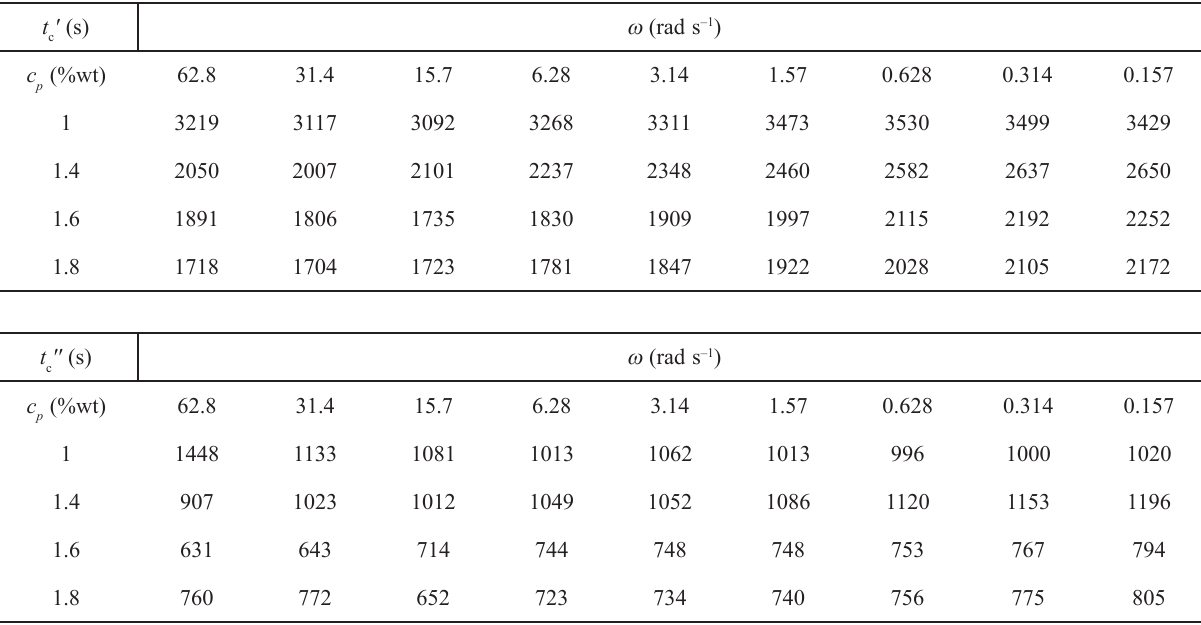
and exponent m obtained from data c